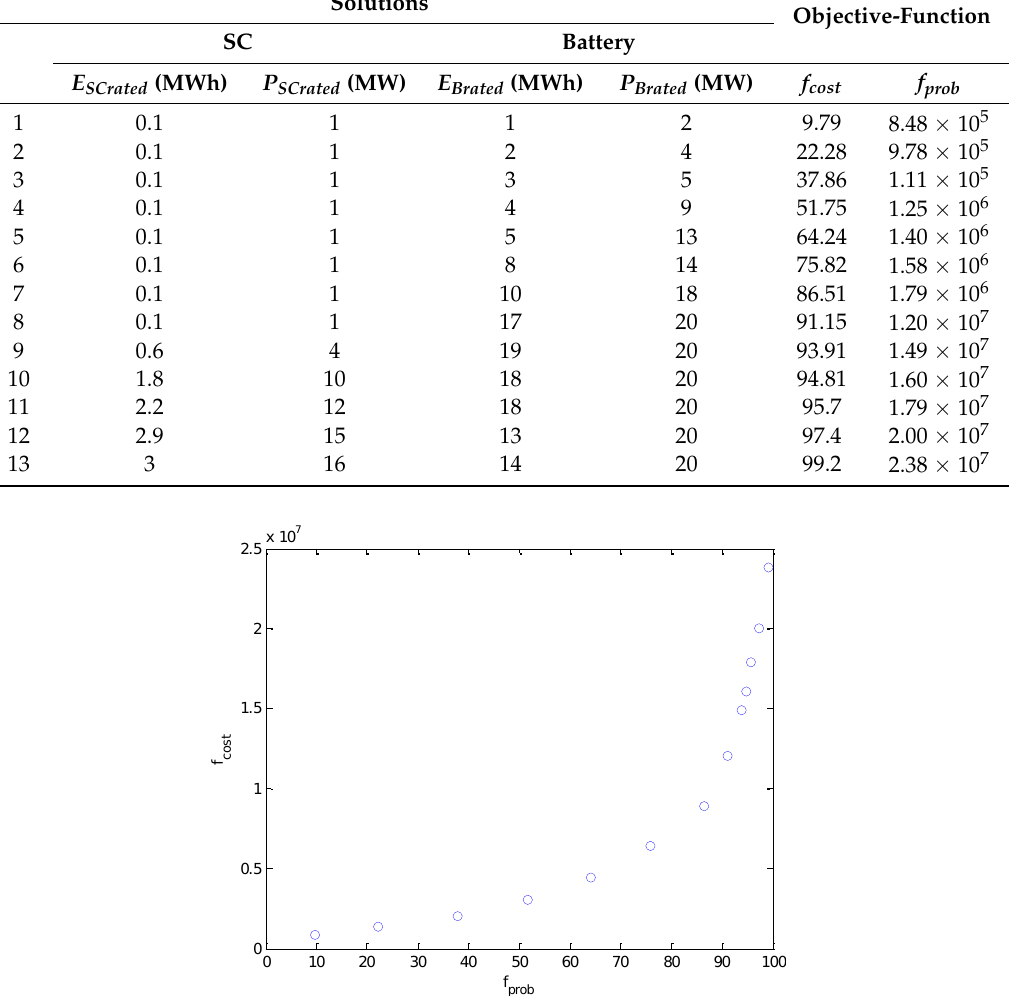
Table 3. Pareto solutions and corresponding objectives.